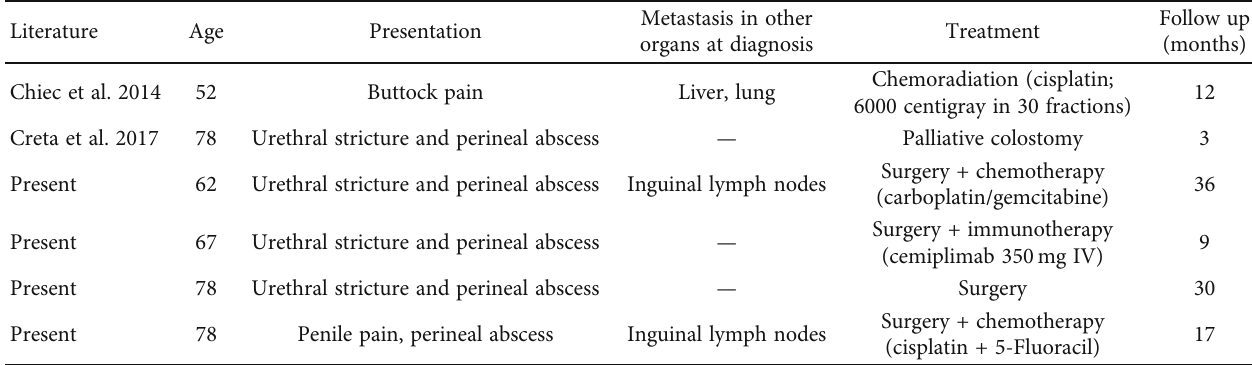
Table 1: Literature